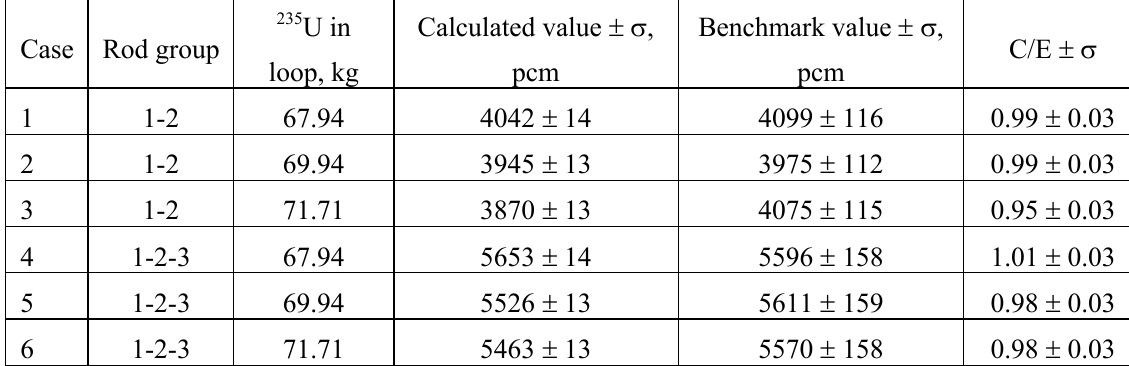
Table II. Control rod bank worth